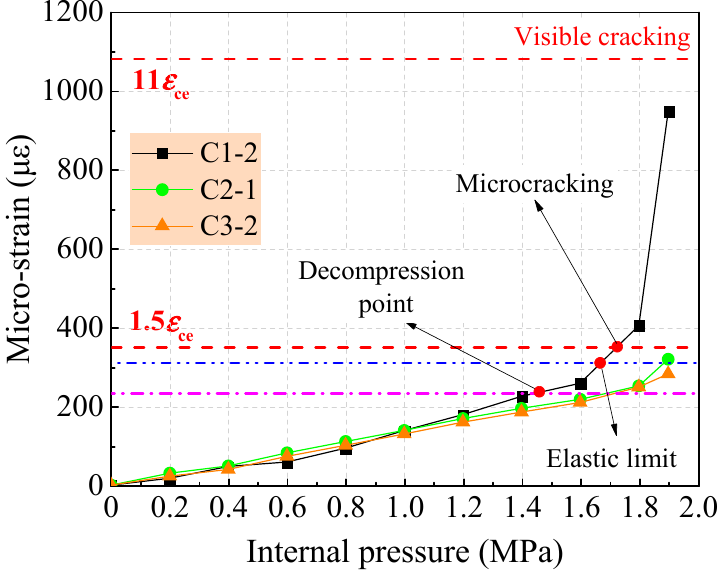
Figure 12. Control strain of outside concrete at each stage.